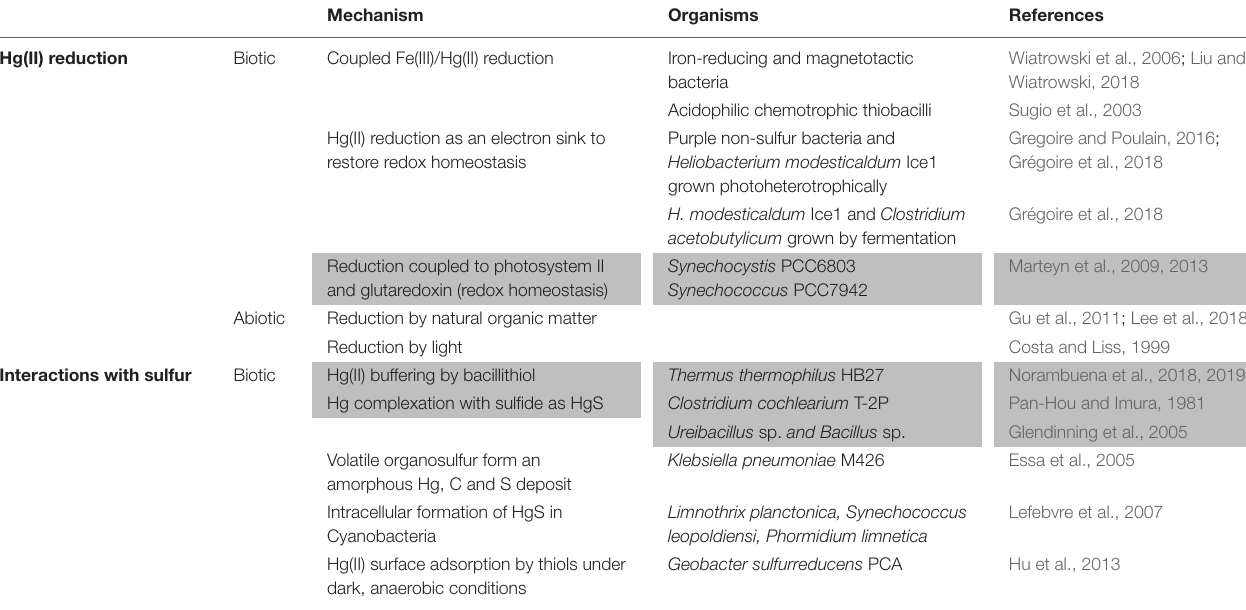
TABLE 3 | Possible Hg(II) detoxification mechanisms independent of the mer system 1 .